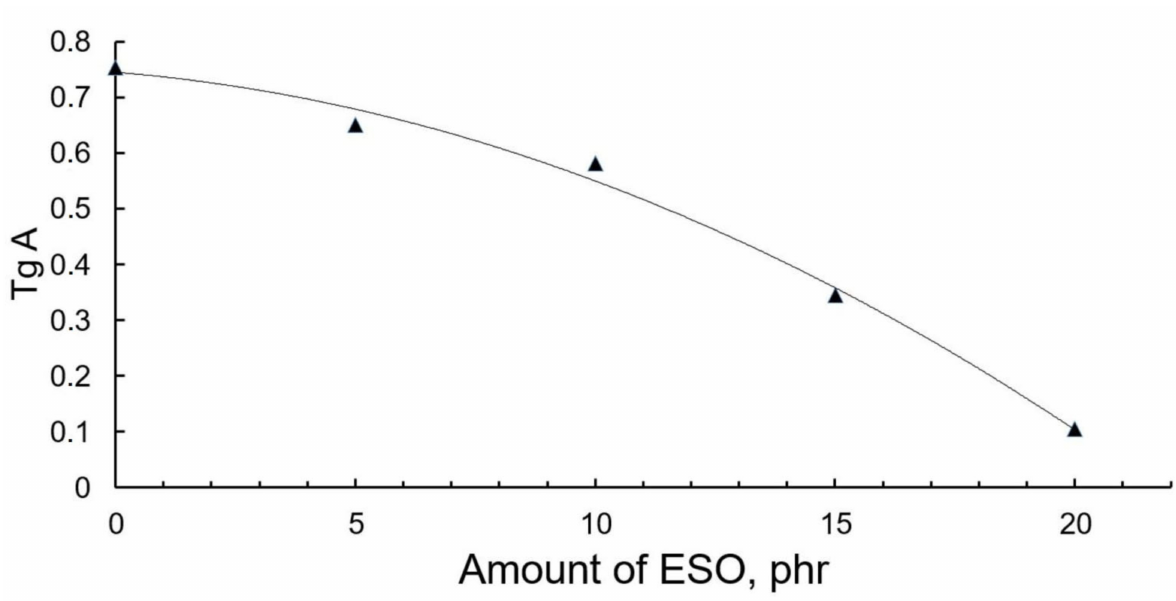
Figure 7. The tgA slope ratio–epoxidized soybean oil (tgA–ESO) content relationship.